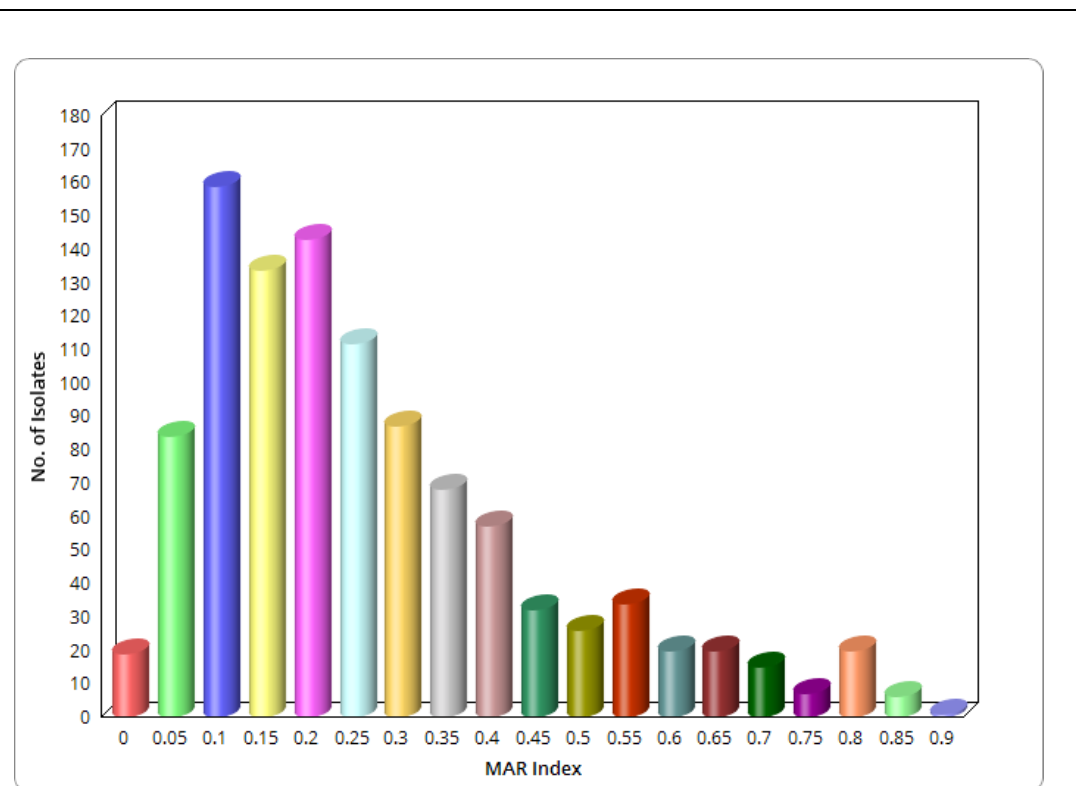
Figure 4. The multiple antibiotic resistance (MAR) indices of E. coli sampled across the farm-to-fork continuum. There was an overall statistically significant difference ( p = 0.000; p < 0.05) between the MAR indexes from the different sampling (Table S1). The multiple pairwise comparison revealed statistically significant differences in the MAR indices between the farm and transport ( p = 0.000; p < 0.05), and farm and abattoir ( p = 0.004; p < 0.05). However, there was no statistically significant difference ( p = 0.092; p < 0.05) between the transport and abattoir MAR indices (Table